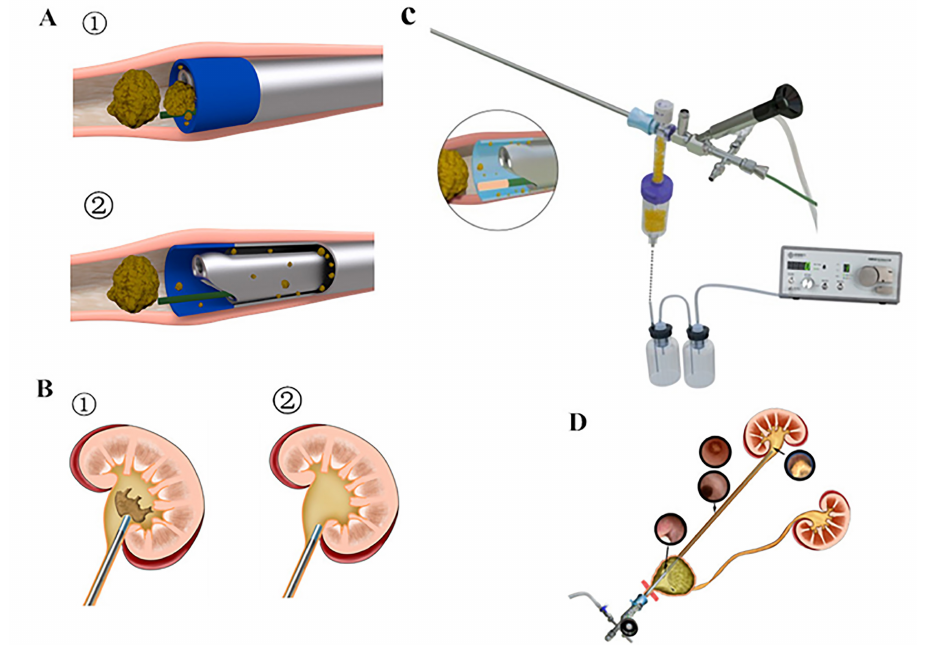
, ) Comparison of ① ②